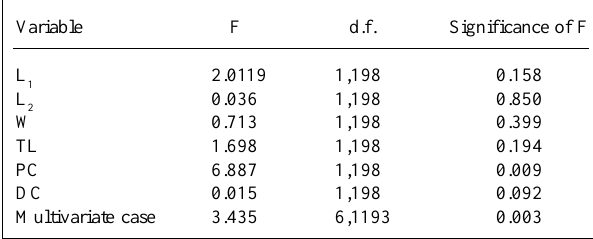
Table VI - Effect of population on the quantitative variables L TL and the meristic variables PC and DC based on the statistical values (F) with degrees of freedom (d.f.). Comparison of Davis 18ºC F and Eureka 18ºC F